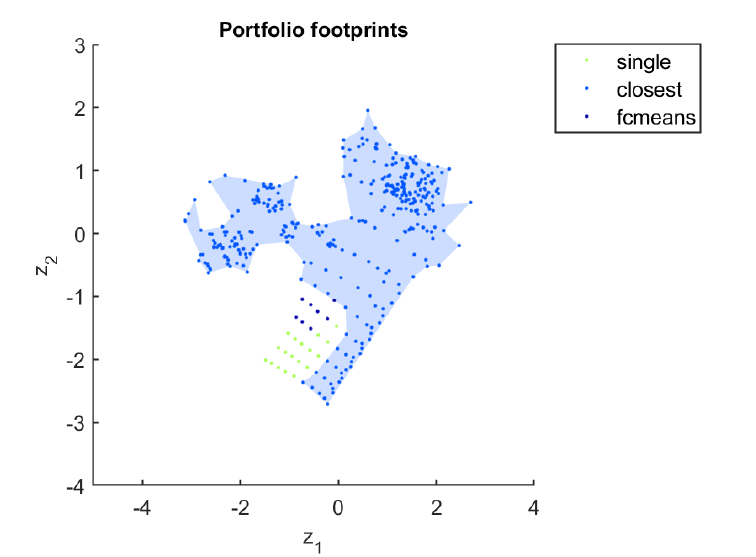
Figure 7. Footprints of the algorithm portfolio predicted by